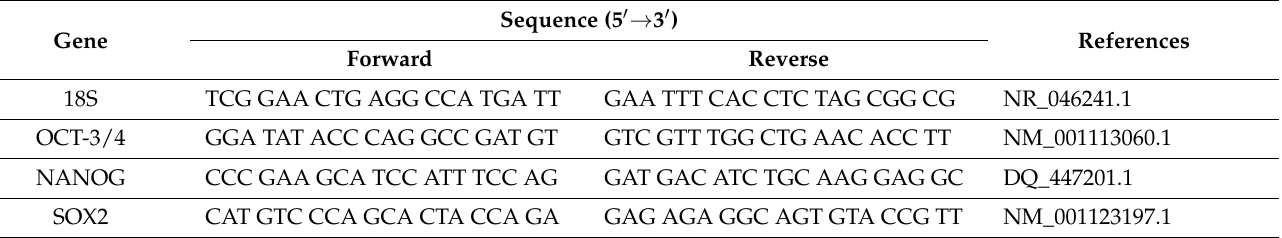
Table 1. Sequences of primers used in